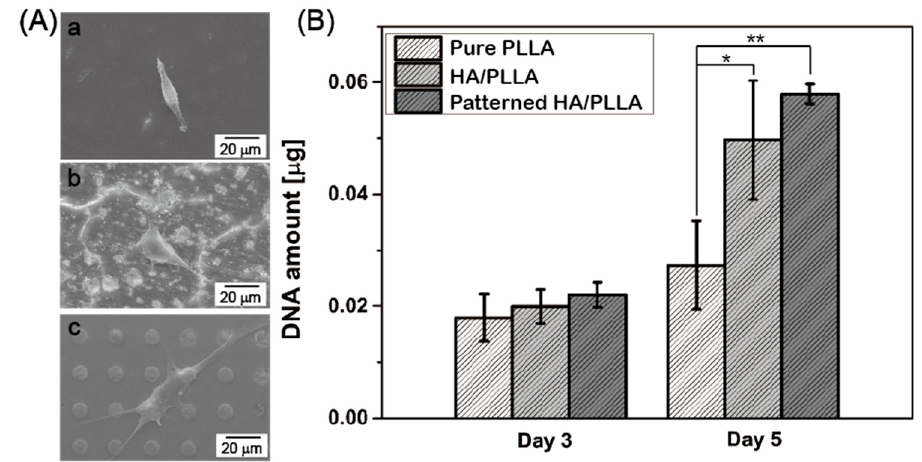
Figure 4. ( A ) SEM images of cell morphology after 1 d of culturing of (a) pure PLLA, (b) HA / PLLA, and (c) patterned HA / PLLA. ( B ) DNA levels of MC3T3-E1 cells after 3 and 5 d of culturing on pure PLLA, HA / PLLA, and patterned HA / PLLA (* p < 0.05, ** p < 0.01).